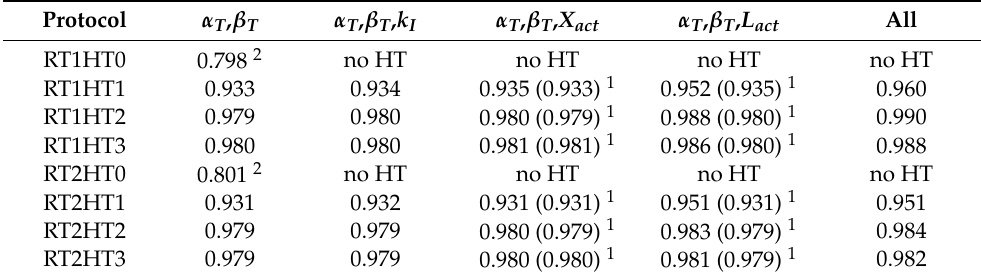
Table 4. TCP values after RT and HT-RT for the different combination of varying parameter values: k I is assumed to be perfusion-limited only (fast process only); the column “all parameters” shows the combined effect of all parameter values modified by HT. Protocols according to Figure 2.